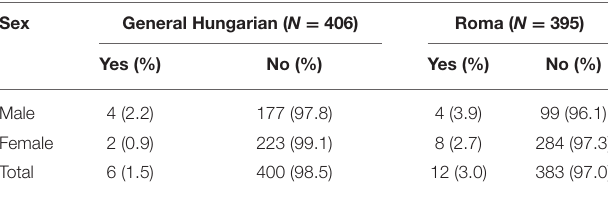
TABLE 2 | Distribution of VTE cases by population and sex among the study